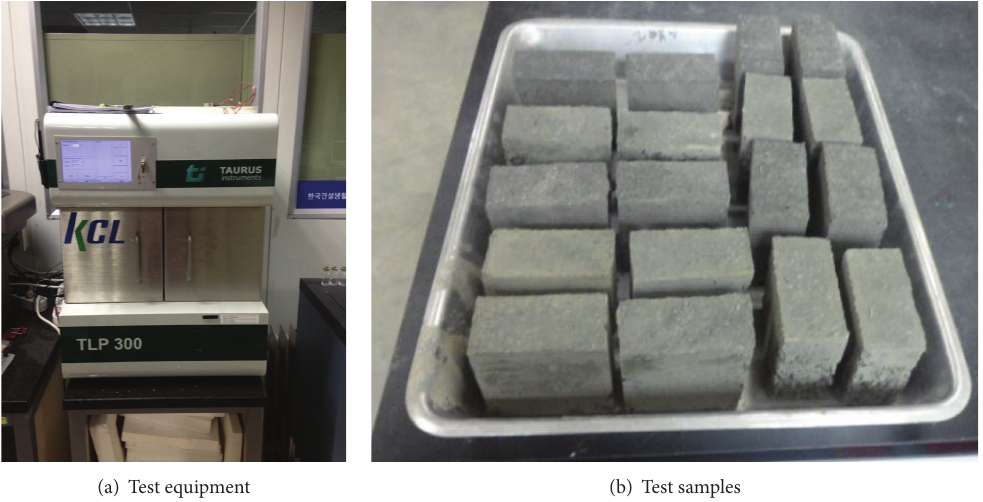
Figure 4: Photos of thermal conductivity measurement and samples.